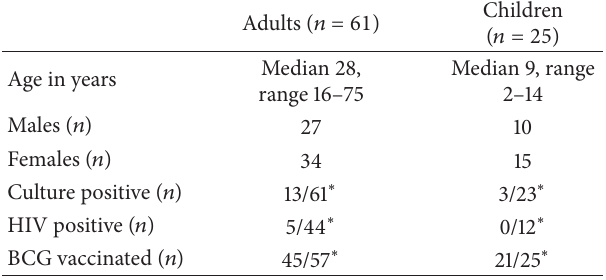
Table 1: The characteristics of the study